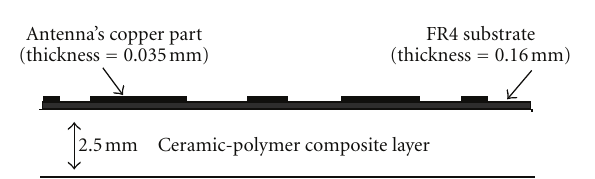
Figure 8: Simulated power reflection coe ffi cient of the RFID tag antenna with 25% and 15% of BaTiO 3 concentration in the composite substrate